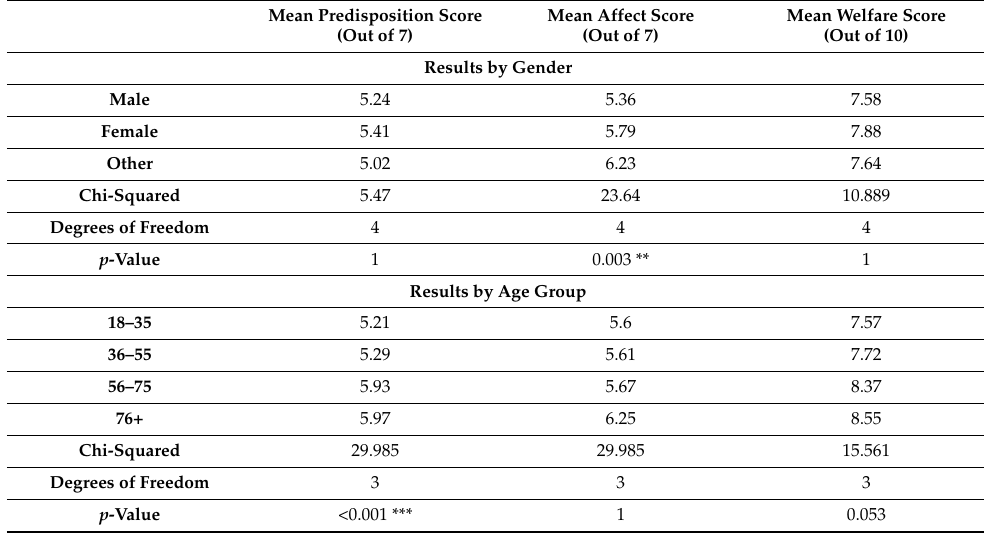
Table 2. Mean predisposition, positive affect, and animal welfare scores across